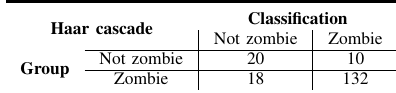
TABLE IV: FACE RECOGNITION RESULTS WITH HAAR CAS-